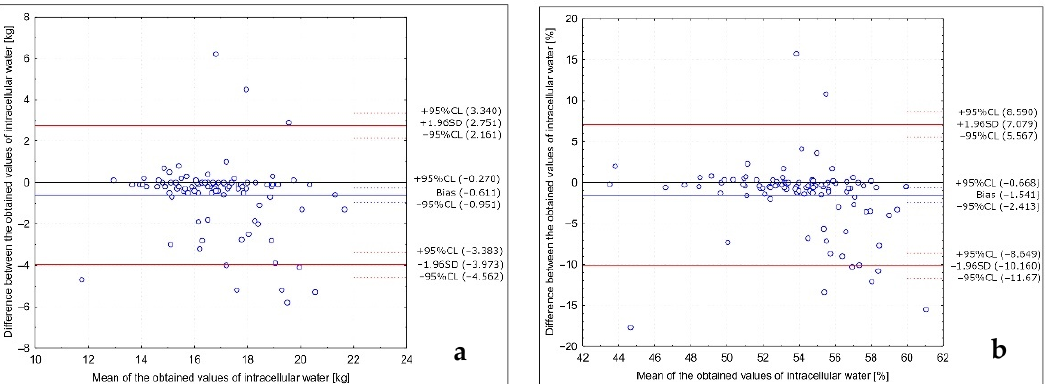
Figure 3. Analysis of the Bland–Altman plots comparing the intracellular water results in the studied group of Caucasian young normal body mass women measured in the follicular phase in various positions (with arms abducted at least 30 ◦ and legs abducted at approximately 45 ◦ ; with arms and legs separated to not touch the body) for the results in kg ( a ) and in the % ( b ). Table 5. Analysis of the quartile distribution of intracellular water results in the studied group of Caucasian young normal body mass women measured in the follicular phase in various positions (with arms abducted at least 30 ◦ and legs abducted at approximately 45 ◦ ; with arms and legs separated to not touch the body).